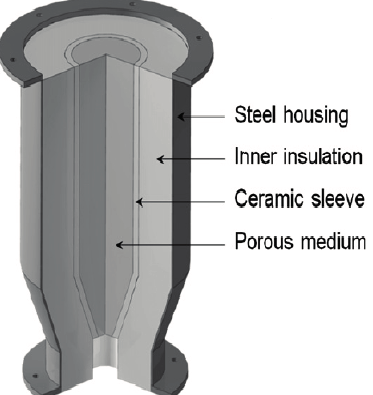
Figure 3. Reformer device for the experimental procedures